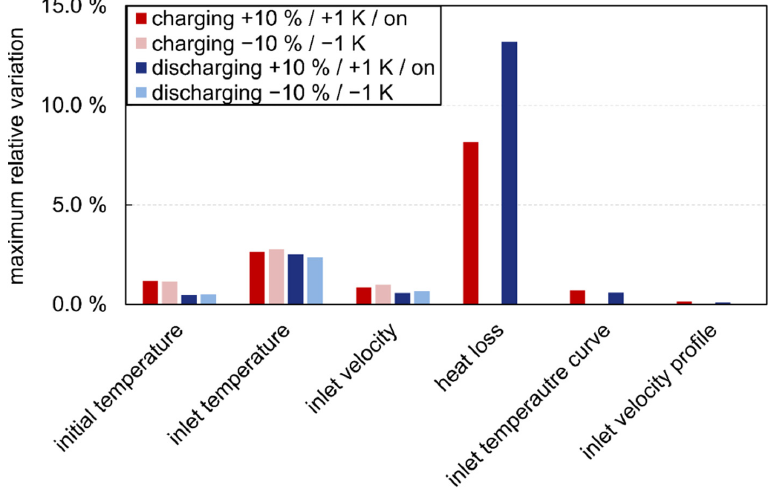
Figure 13. Absolute maxima of the relative variation of the global liquid fraction for charging and discharging when varying the boundary and initial conditions.